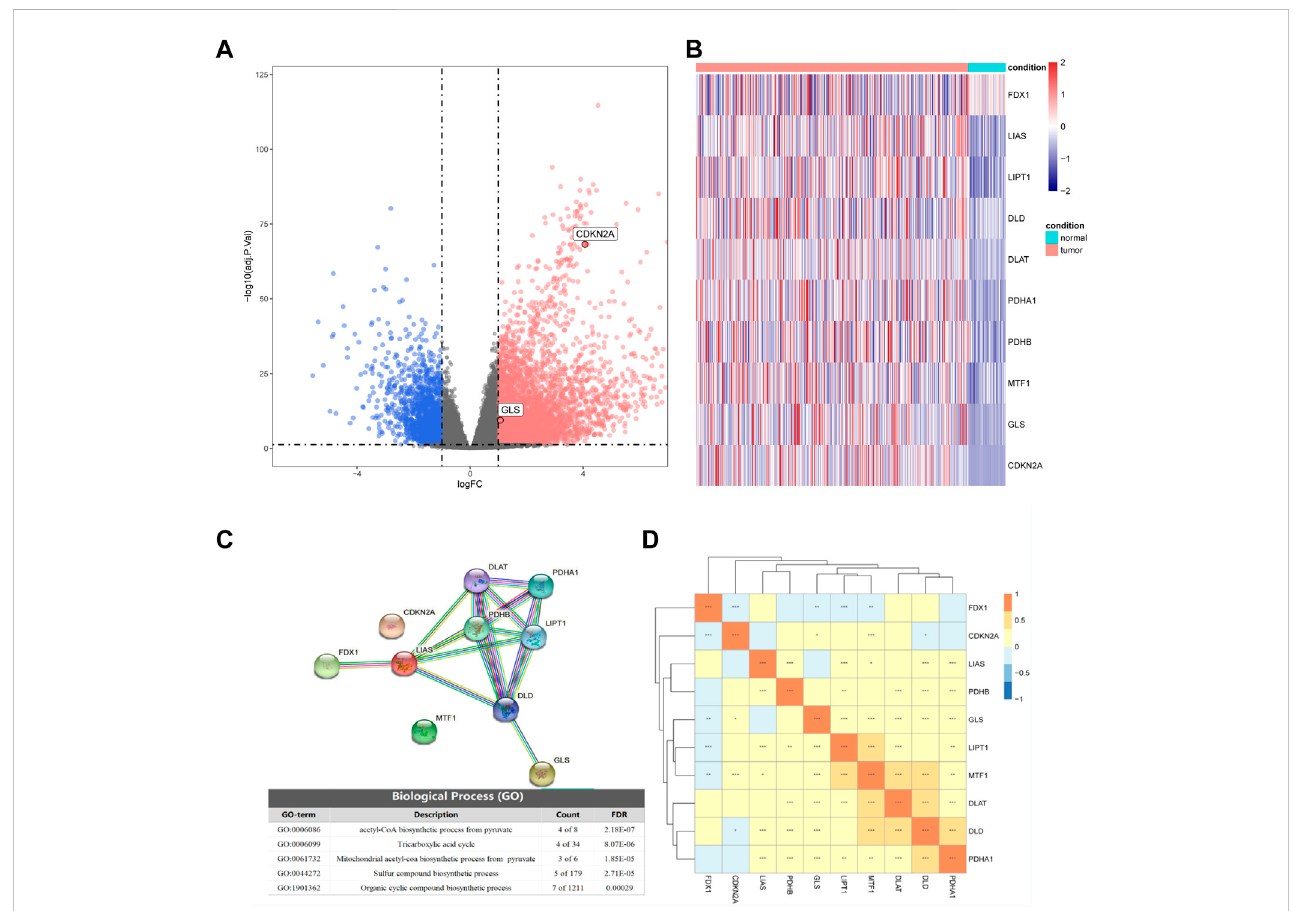
FIGURE 1 Differential expression of cuproptosis-related genes in hepatocellular carcinoma (HCC) and normal tissues. (A) Volcano plot of differential expression (blue represents downregulation in HCC, red represents upregulation in HCC, gray represents insigni fi cant, and cuproptosis-related genes are marked in the fi gure). (B) Theexpressionof10cuproptosis-relatedgenesinHCCandnormaltissues. (C) Partialresultsofprotein-proteininteractions(PPI)networkmapand gene ontology (GO) enrichment of 10 cuproptosis-related genes. (D) Heatmap of expression correlation of 10 cuproptosis-related genes in